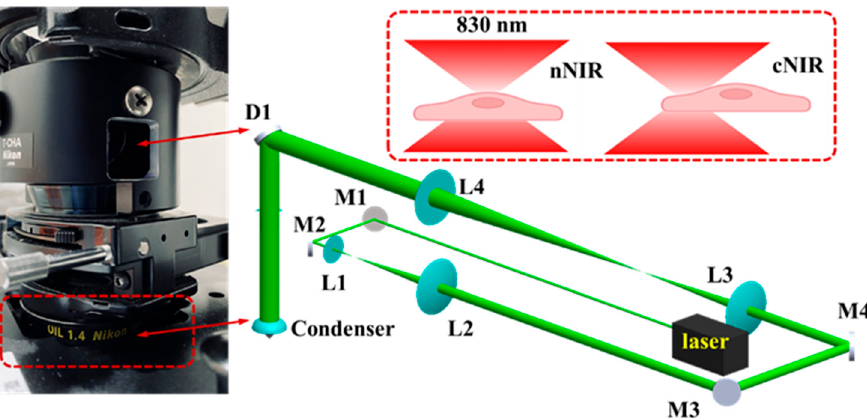
Figure 1. The experimental setup for the single-cell NIR laser irradiation system consists of an 830 nm infrared diode laser, an electrical shutter, laser-focusing optics (condenser), and a specimen holder attaching to the XY-axis motorized stage. The laser beam is expanded eightfold with lens pairs from the combination of 1:4 telescope (L1:L2) and 1:2 telescope (L3:L4) to slightly fill the back aperture of the condenser, where the dichroic mirror D1 is placed above the condenser to reflect the laser beam into the condenser while transmitting visible light for bright-field imaging. The upper right is the two operation modes for the single-cell NIR laser irradiation: the laser focal spot is located either in the nucleus (nNIR) or in the cytosol (cNIR) of single cell.